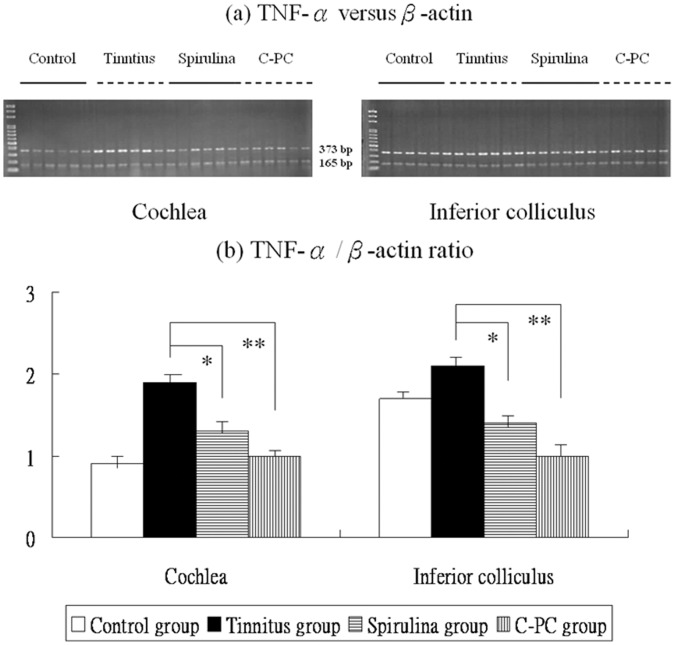
The levels of TNF-α mRNA expression in the four groups (a,b).There are significant differences in these levels among the four groups. The TNF-α mRNA expression were significantly higher in the salicylate group than the control group. Compared to the tinnitus group, the Spirulina group (*) or C-PC group (**) exhibits significantly reduced TNF-α mRNA levels in the cochlea and IC.